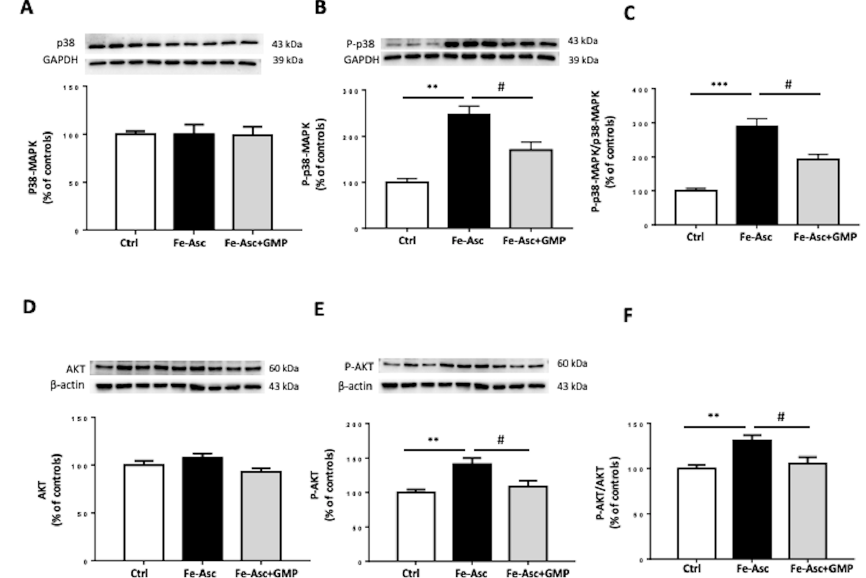
Figure 4. E ff ects of GMP on insulin sensitivity in Caco-2 / 15 cells. Caco-2 / 15 cells were pre-incubated for 18 h before treatment with Fe / Asc (200 µ M / 2 mM) +/ − GMP (2 mg / mL) for 6 h at 37 ◦ C. Two hours before the end of the six hour-incubation with Fe / Asc, insulin (100 nM) was added to evaluate insulin sensitivity as described in Materials and Methods. Protein expression of ( A ) p38-MAPK, ( B ) phospho-p38-MAPK, ( D ) AKT and ( E ) phospho-Akt was determined by Western blot. ( C ) Phospho p38-MAP / p38-MAPK and ( F ) phospho-Akt / AKT ratios were calculated. Results represent the means ± SEM of n = 3 independent experiments in triplicate. ** p < 0.01, *** p < 0.001 vs. Controls (Ctr); # p < 0.05 vs. Fe / Asc Caco-2 cells treated with insulin.